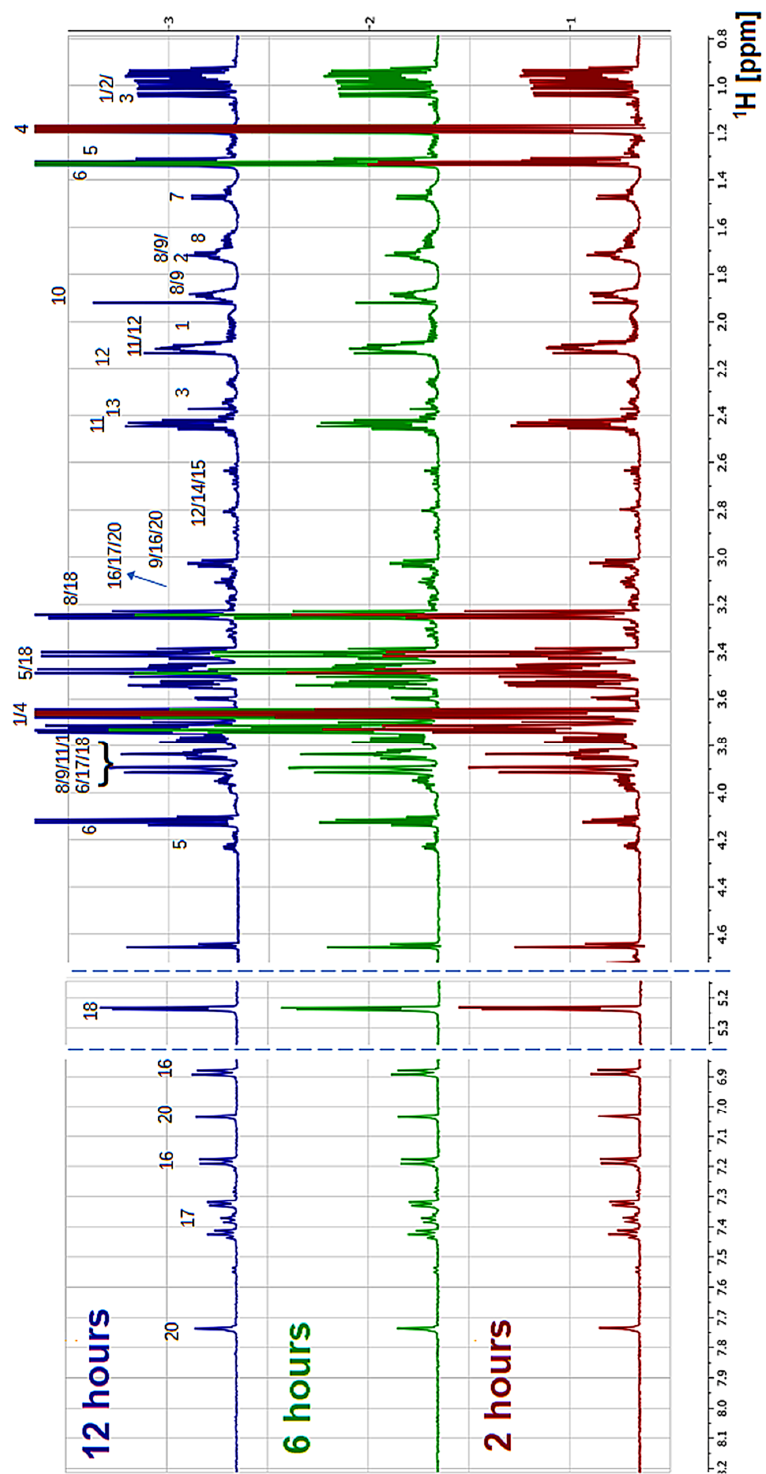
Figure 3. Reference NMR spectra from infected cells at 2 (brown), 6 (green), and 12 h (blue) post infection. Metabolite identification followed the aforementioned protocol. A total of 20 metabolites